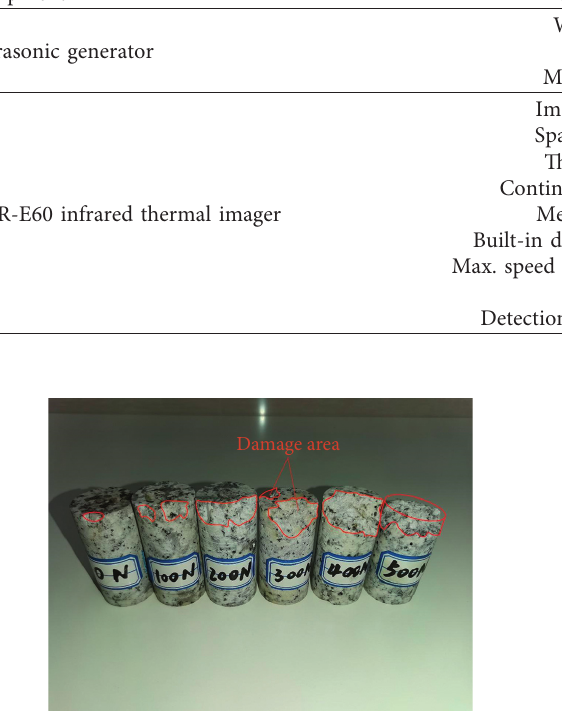
Figure 6: Fragmentation of granite under ultrasonic load under different pressures.